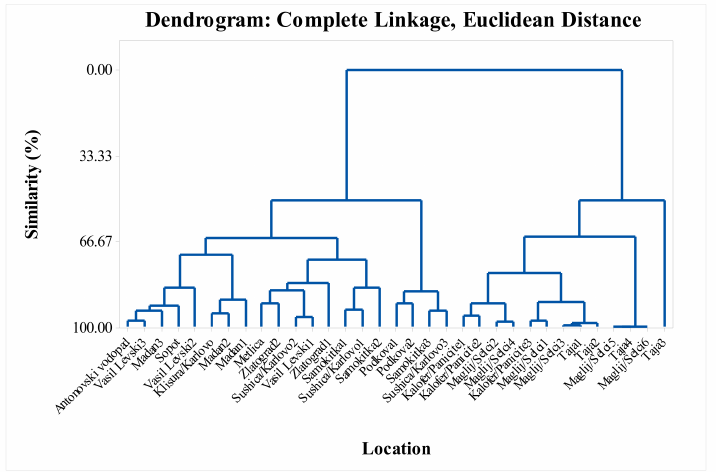
Figure 6. Complete linkage dendrogram showing the similarity of 33 locations in terms of thymol, p -cymene, and γ -terpinene of Satureja pilosa